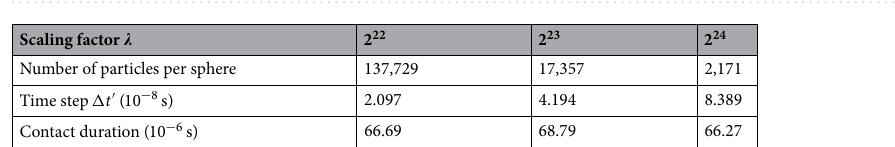
Figure 3. Snapshots of the melting slab. Green dots are aluminum atoms, and red dots are wall atoms on which the energy is added via the velocity rescaling. ( a ) The original system ( (cid:31) 2 1 . ( c ) (cid:31) 2 2 . Left) Initial state. All the particles form a crystalline structure, which indicates that the with (cid:31) = = slab is solid. (Middle) The slabs start to melt from surfaces. Liquid regions of three cases have approximately the same thickness. (Right) The solid regions almost completely melted. Thickness of the melted slabs remain the same for all three cases.